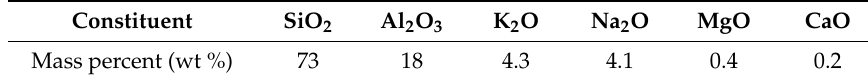
Table 1. Chemical composition of EP.